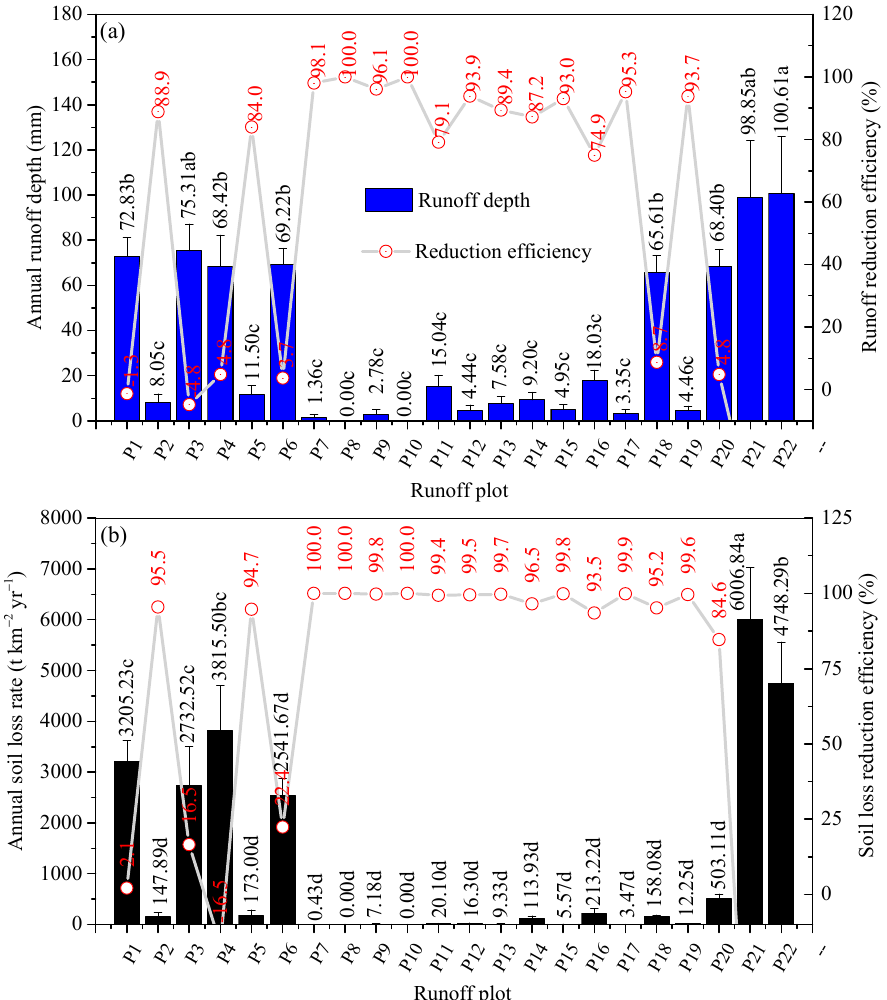
Figure 4. Annual runoff depth ( a ) and annual soil loss rate ( b ) and their reduction efficiencies by soil conservation measures in comparison to the mean values of bare plots 3 and 4 in 2014–2020 for the 22 runoff plots. Notes: the bars represent standard error. The average values on the columns with the same letter are not significantly different at p = 0.05, as determined by Fisher’s protected least test.